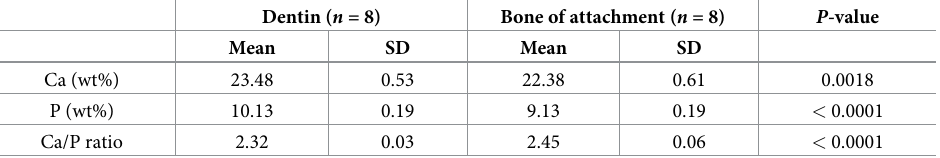
Table 1. Calcium (Ca) and phosphorus (P) concentrations (normalized values) obtained by SEM-EDS for dentin and bone of attachment (eight measurement spots each, for location see Fig 7) of a left first dentary tooth of Ano- plogaster cornuta and Ca/P ratios for the two tissues. P -values (two-tailed) are from unpaired t-tests.